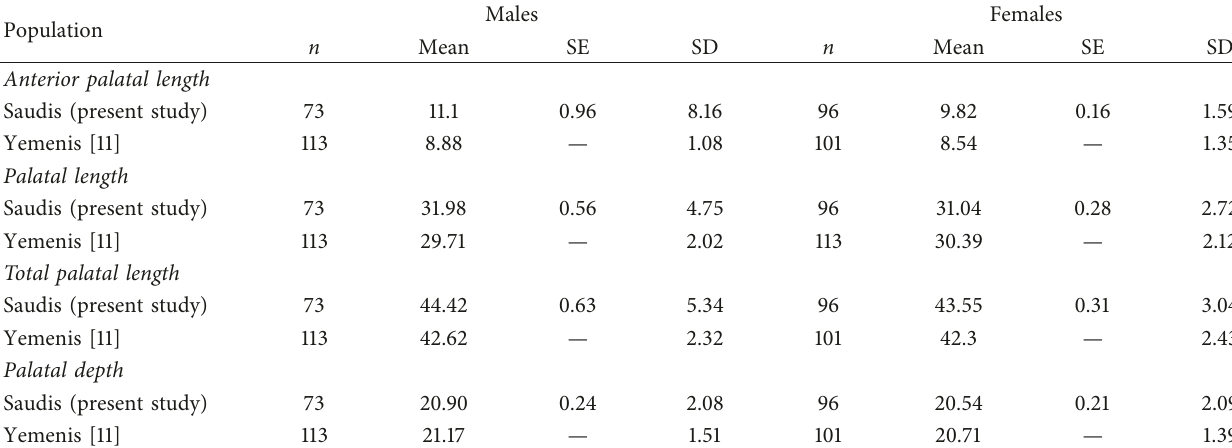
Table 9: Comparisons of maxillary arch length and depth between Saudis and Yemenis. Population